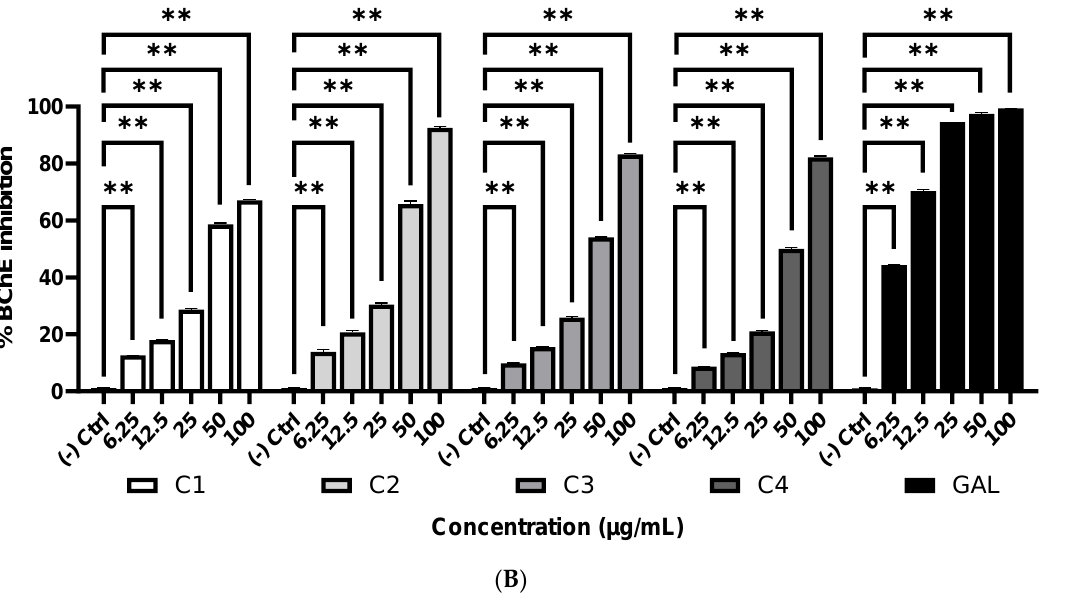
Figure 4. Cholinesterase inhibitory activities of the compounds 1 - 4 and standard. ( A ) Inhibition of acetylcholinesterase (AChE). IC 50 (µg/mL): 1 , 48.79 ± 0.24; 2 , 34.82 ± 0.45; 3 , 44.49 ± 0.71; 4 , 44.91 ± 0.14; DON, 7.11 ± 0.24. ( B ) Inhibition of butyrylcholinesterase (BChE). IC 50 (µg/mL): 1 , 46.40 ± 0.35;